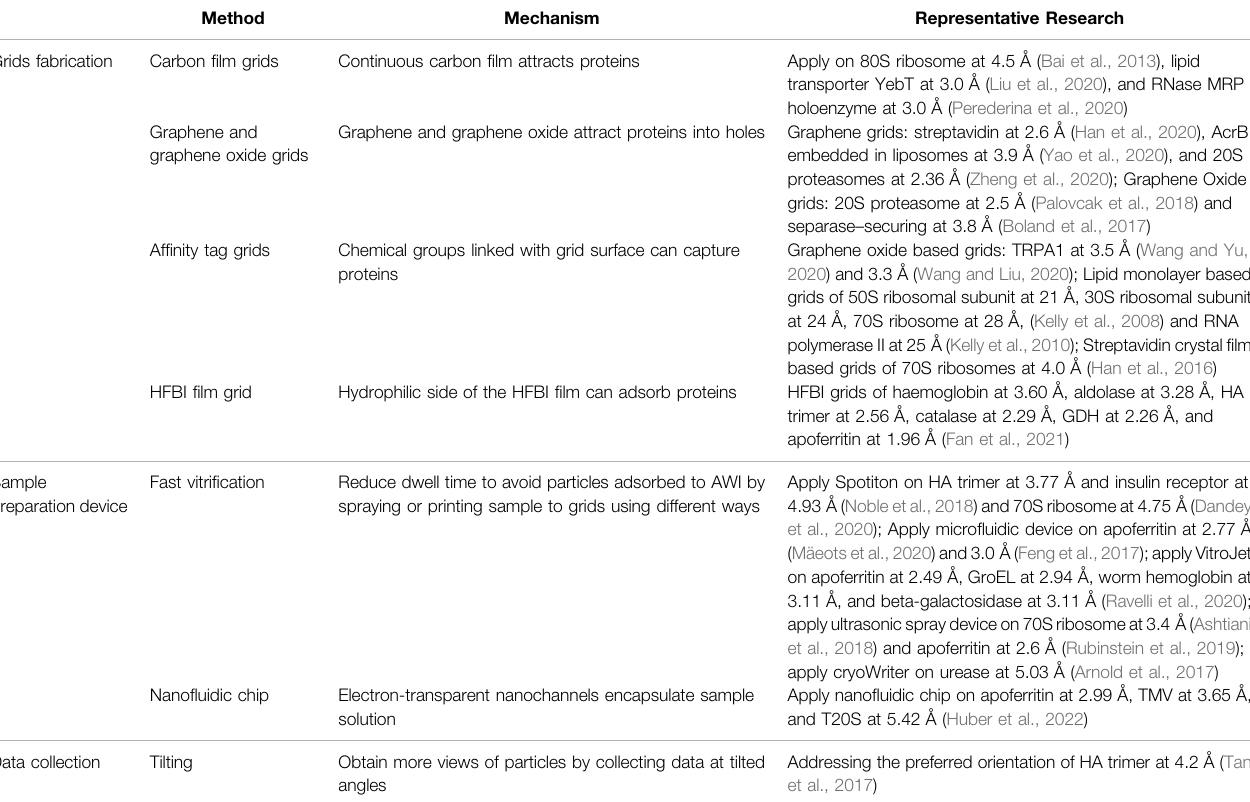
TABLE 2 | Summary of methods in grid fabrication, device development, and data collection to improve the quality of cryo-specimen.